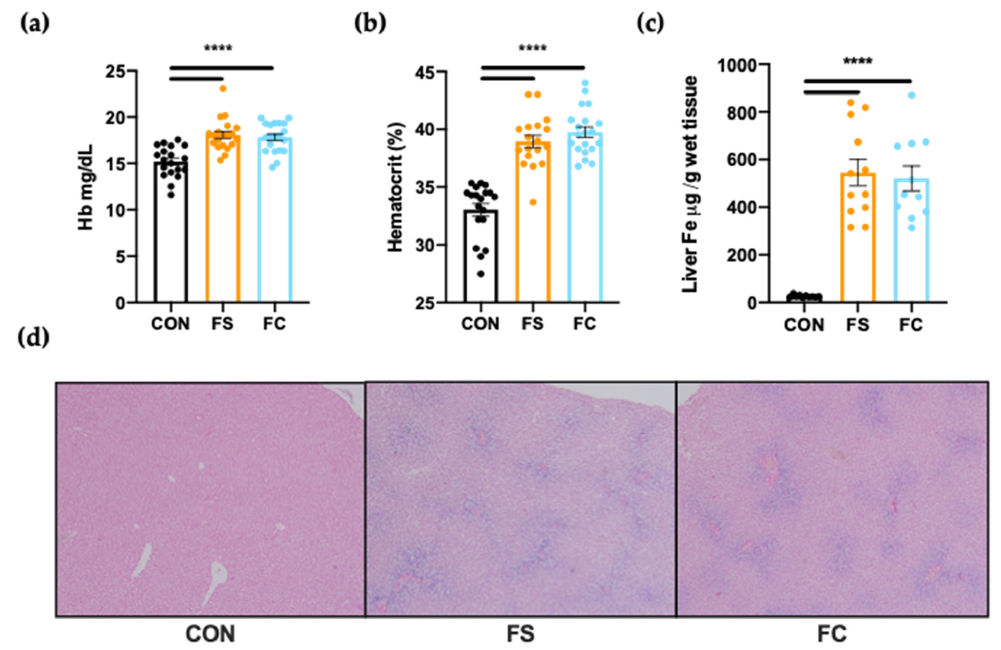
Figure 1. Iron status on postnatal day (PD) 15 following daily ferrous sulfate (FS), ferrous bis-glycinate chelate (FC), or vehicle control (CON) supplementation in rats from PD 2–14. ( a ) Hemoglobin and ( b ) hematocrit were measured from fresh whole blood ( n = 20/group). ( c ) Liver iron concentrations were quantified by atomic absorption spectrometry ( n = 12/group). Values are plotted as the means ± SEM. ( d ) Representative microscope images of liver sections stained with Perls’ Prussian blue for the detection of ferric iron deposits were captured using a 10× objective lens ( n = 6/group). p -value summary: ****, p < 0.0001.